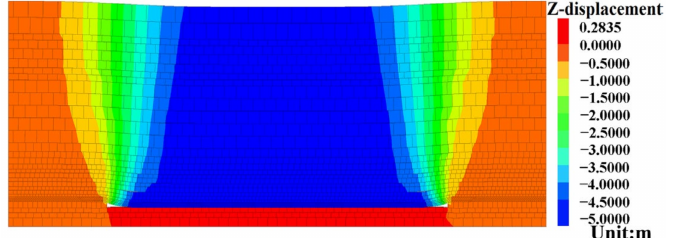
Figure 6. Subsidence conditions of overlying strata after complete excavation of the strike